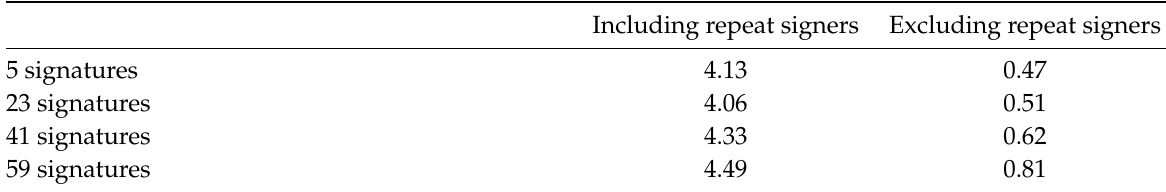
Table 1: Average number of third-party signatures by number of assigned signatures. N =